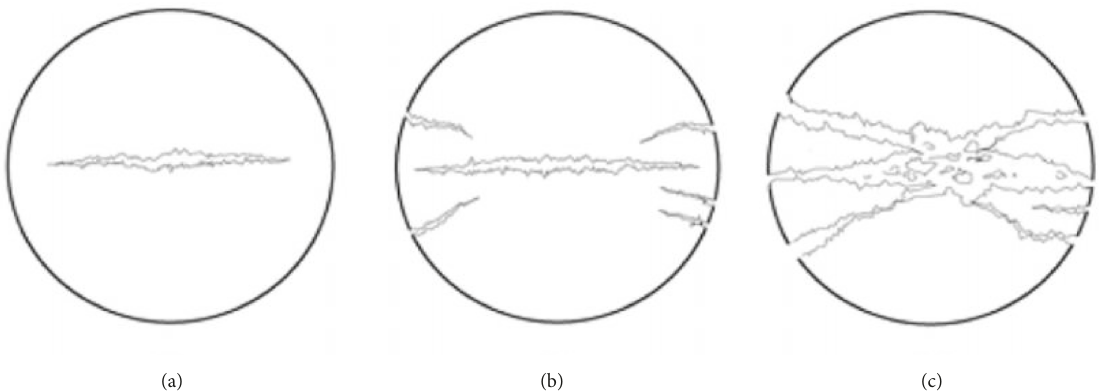
Figure 8: Schematics of failure model of specimen [15]: (a) initial cracks; (b) crack propagation; (c) crack